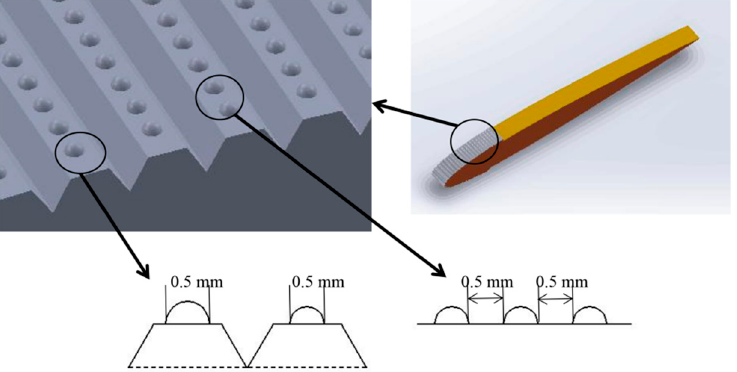
Figure 5. Bionic coating of VC-type.